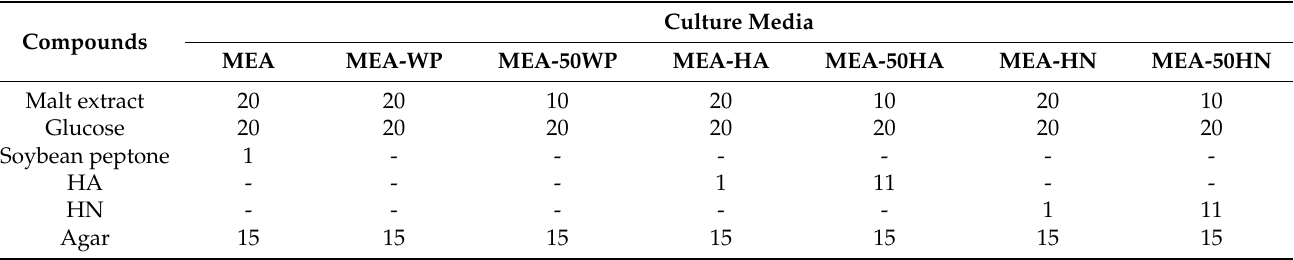
Table 2. Composition of the culture media (g/L) tested based on MEA for the evaluation of HA and HN.